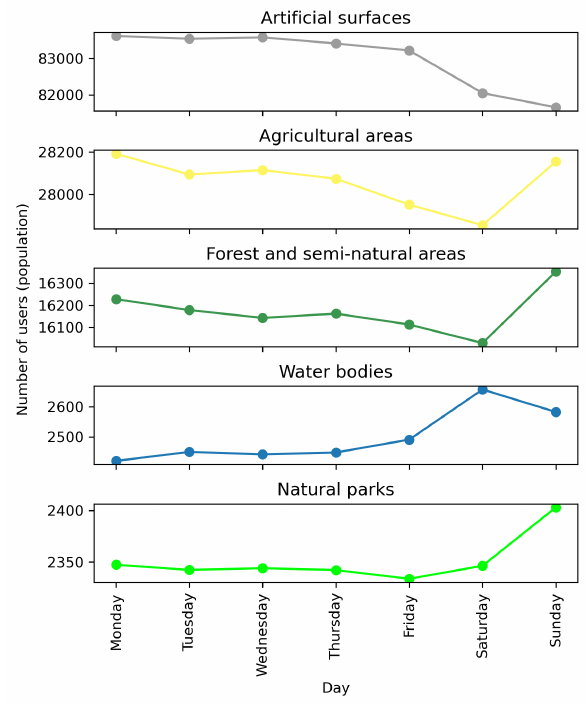
Figure 5. Average users’ population by day of the week in each CLC class and natural park areas of the Insubria region.